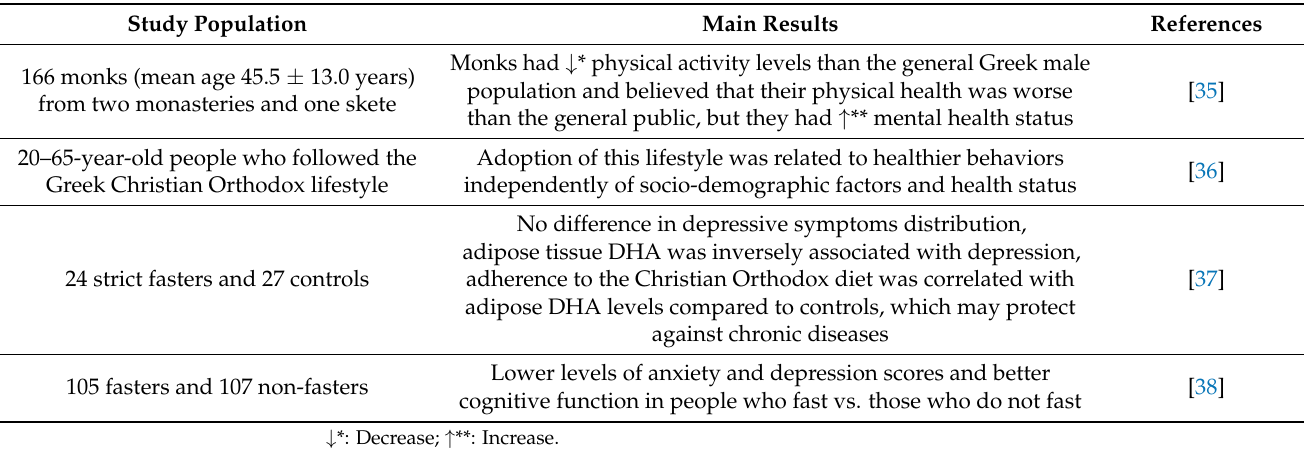
Table 4. Studies concerning the impact of Christian Orthodox fasting on well-being.